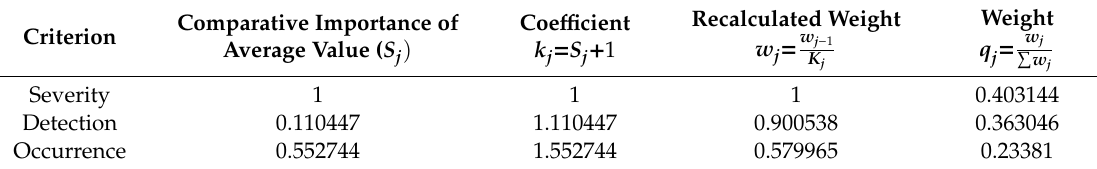
Table 3. Results of SWARA method in weighting assessment by FMEA team member 1.